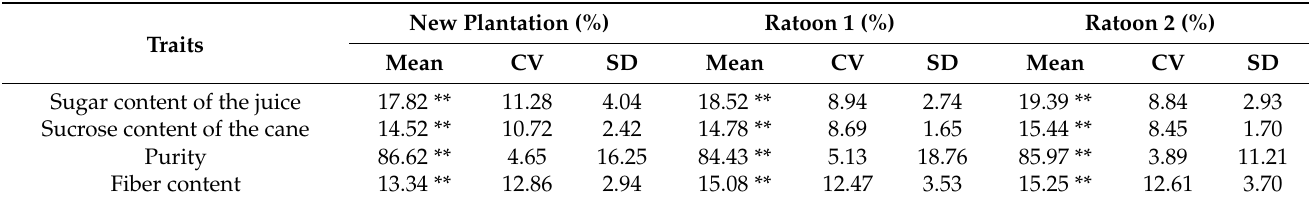
Table 3. Analysis of variance of four technological traits in 100 sugarcane